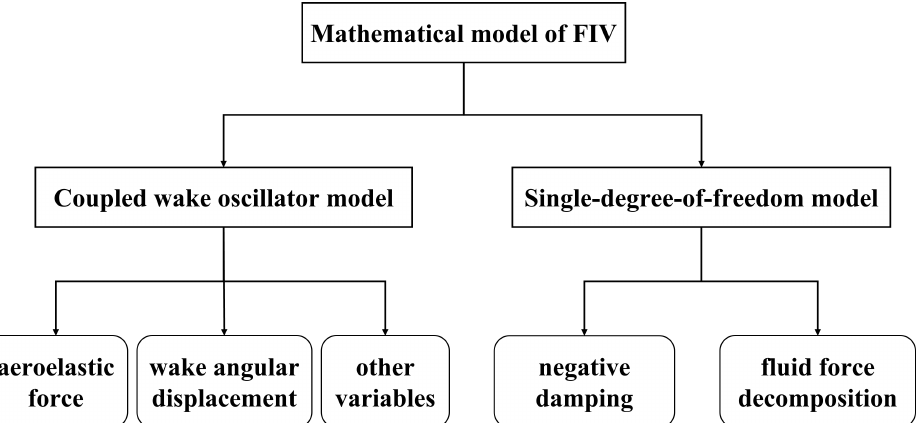
Figure 2. Proposed classification of mathematical modelling of FIV used to predict the flow-induced vibration of a bluff